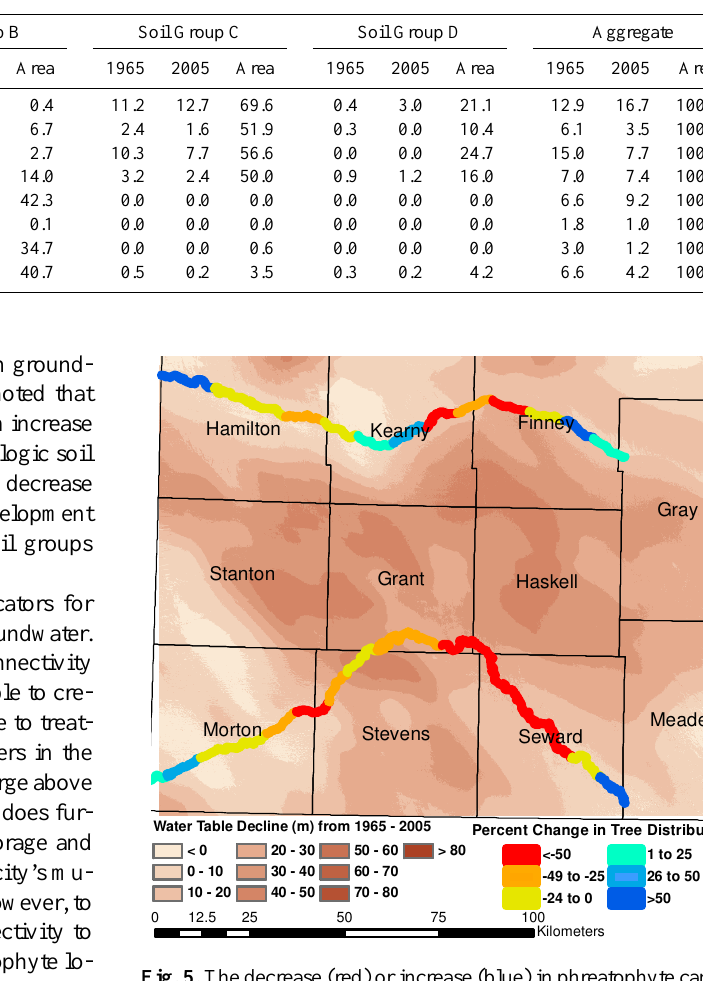
Fig. 5. The decrease (red) or increase (blue) in phreatophyte canopy area between predevelopment and post-development correlates with changes in the depth to groundwater, and substantiates the occurrence of high recharge zones.